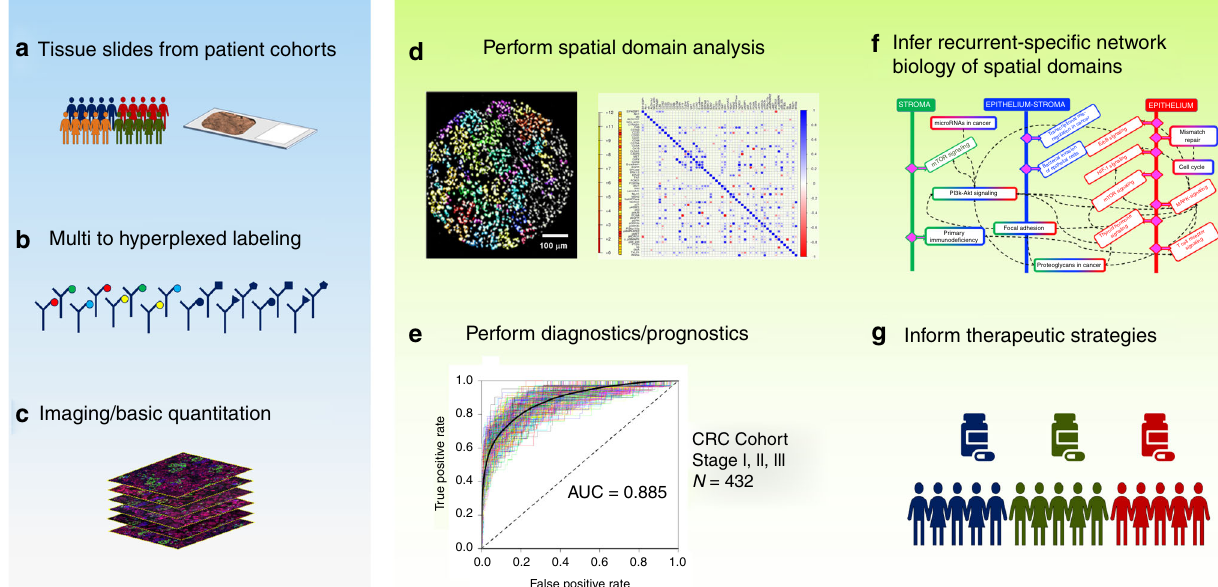
Fig. 7 Work fl ow of SpAn computational and systems pathology platform. a – c SpAn utilizes images of resected primary tumors from TMAs or whole slide images based on hyperplexed fl uorescence and other imaging modality platforms 18 – 21 to d perform spatial-domain analysis for e patient diagnoses and prognoses and f infer recurrence-speci fi c spatial-domain networks to g potentially inform therapeutic